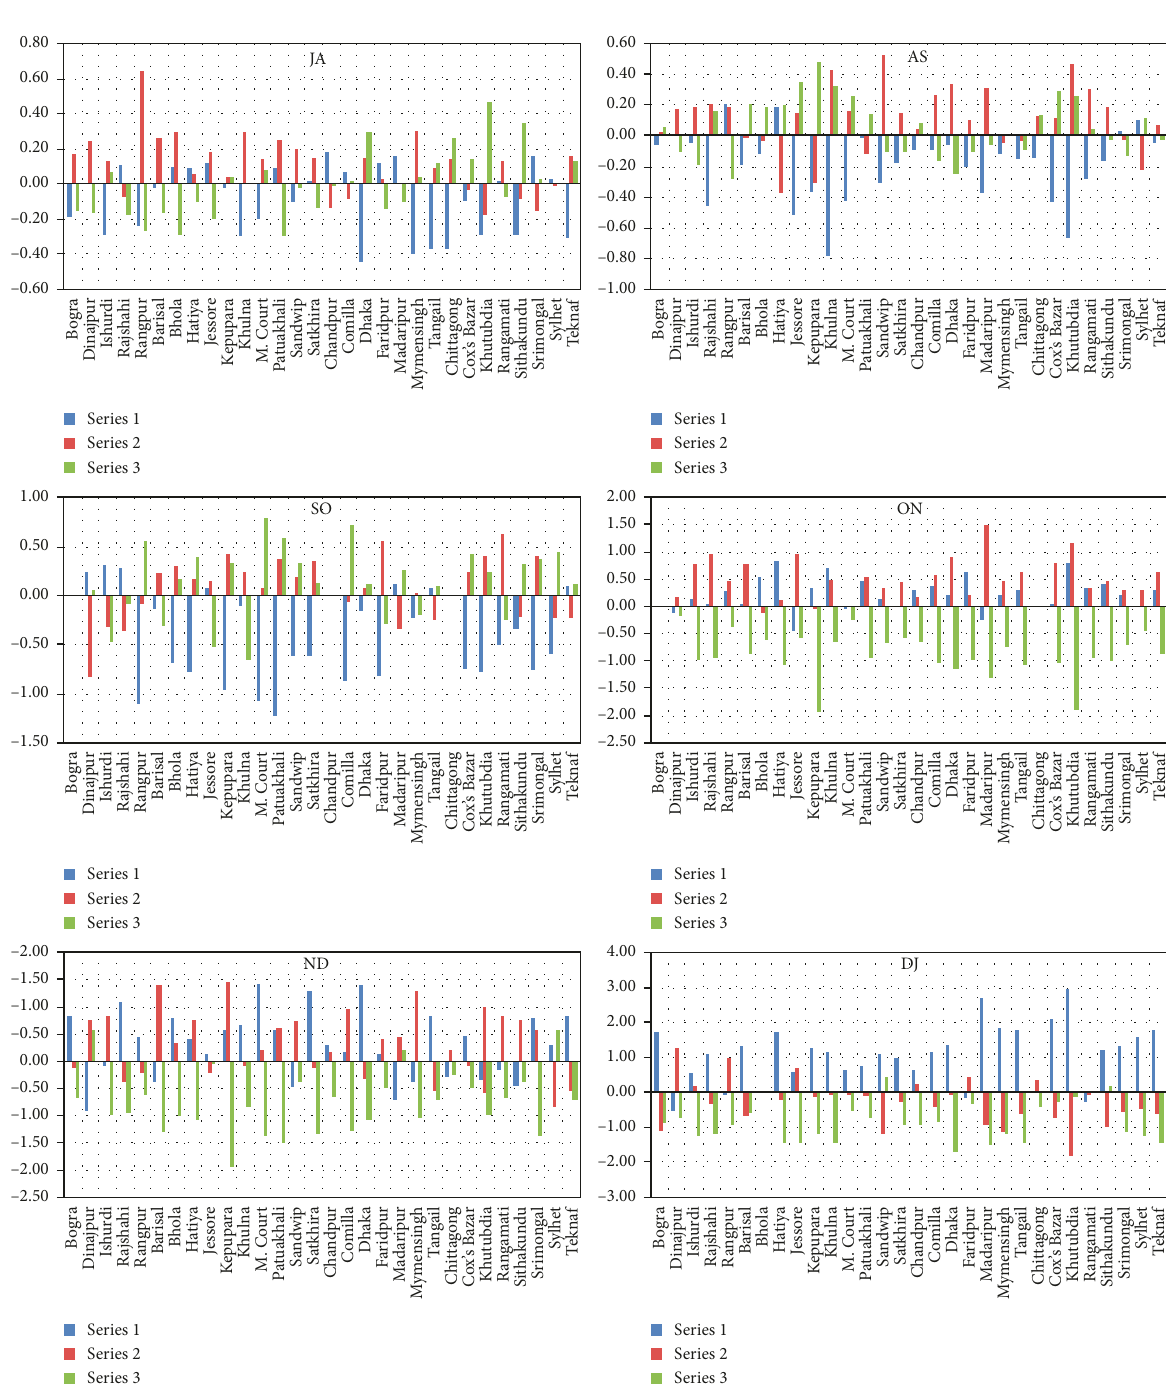
1980–1989, series 2 1990–1999, (cid:31) (cid:31)